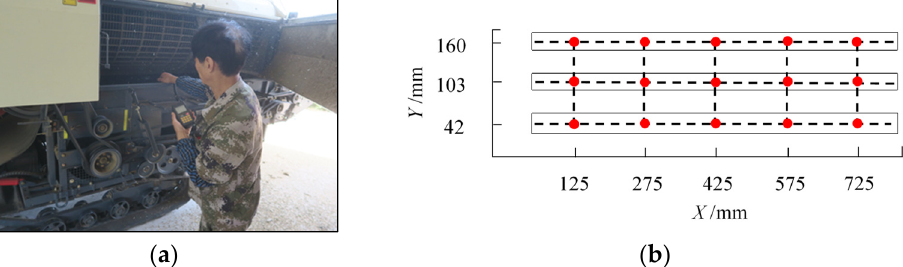
Figure 7. Air velocity measurement site and measurement points distribution. ( a ) Air velocity measurement. ( b ) Measurement points distribution.